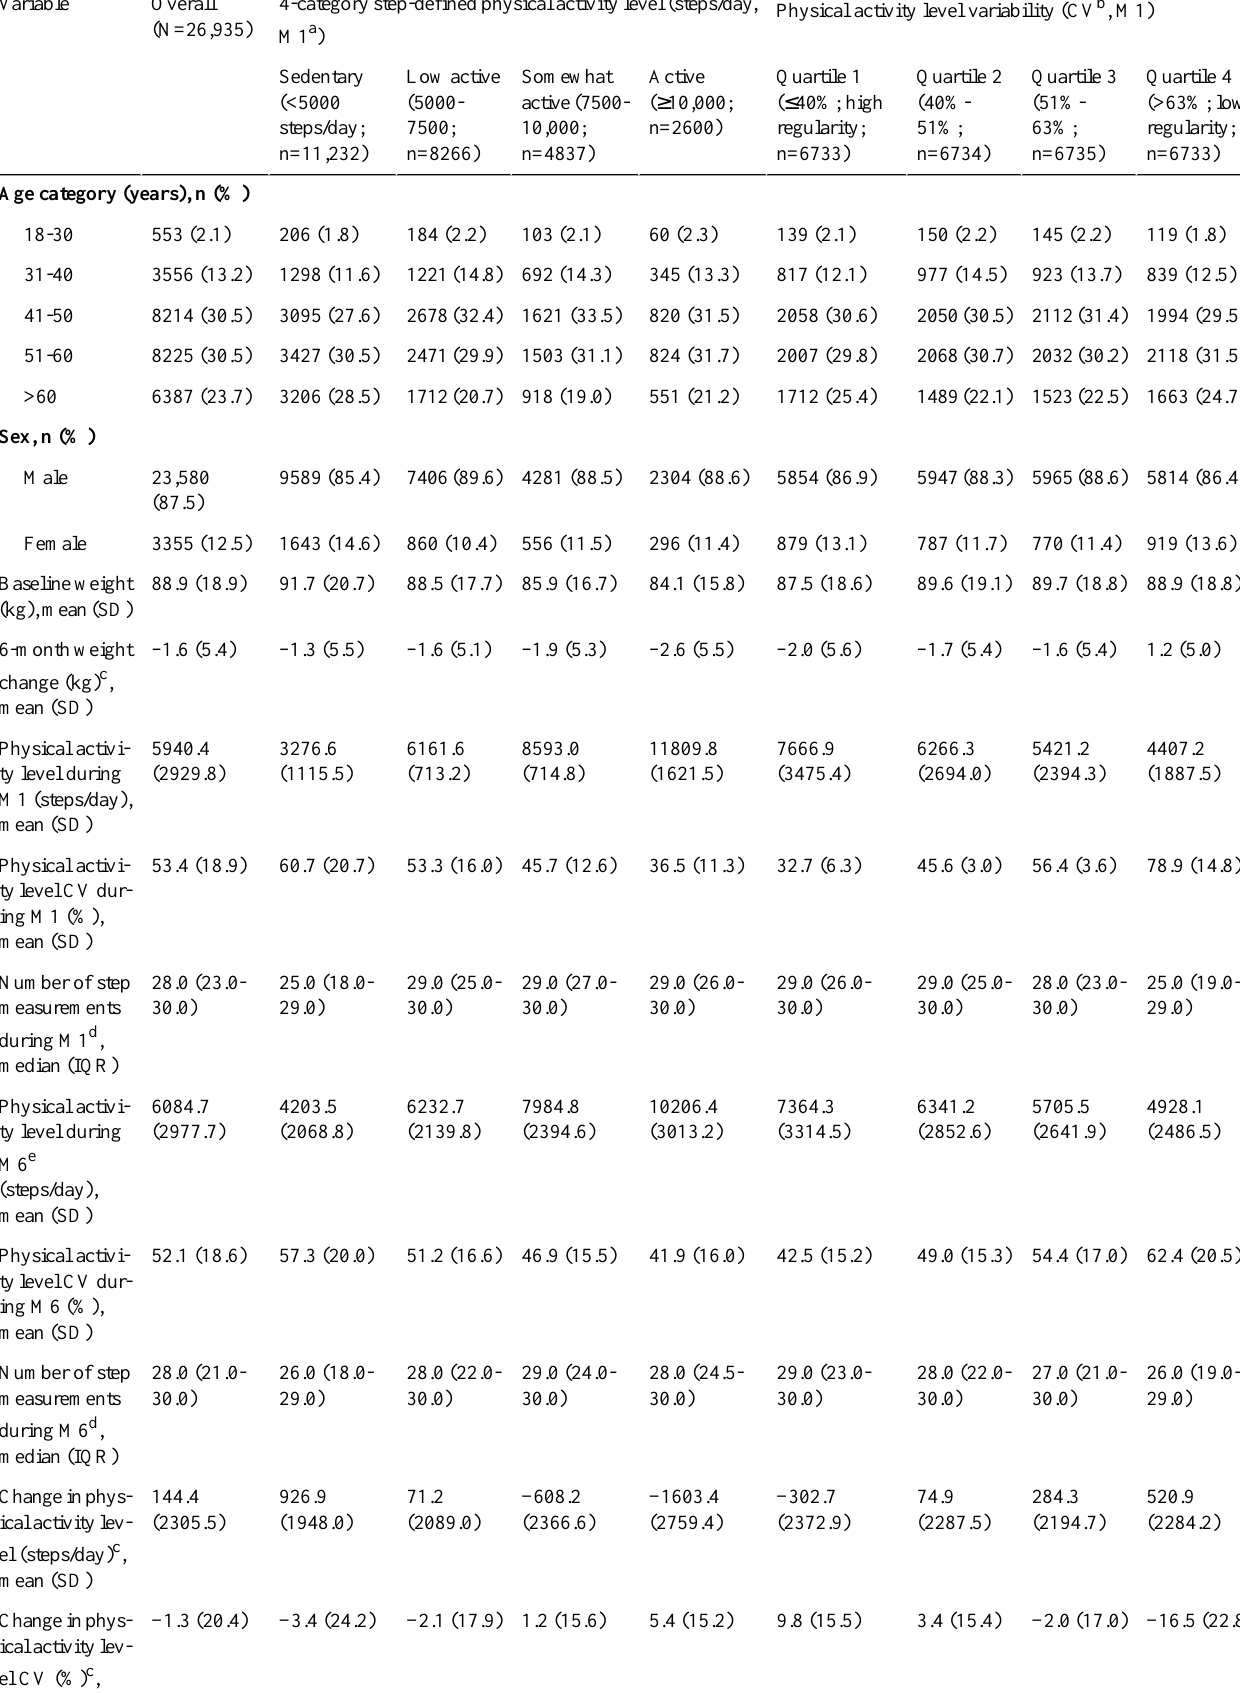
Table 1. Characteristics of the study population